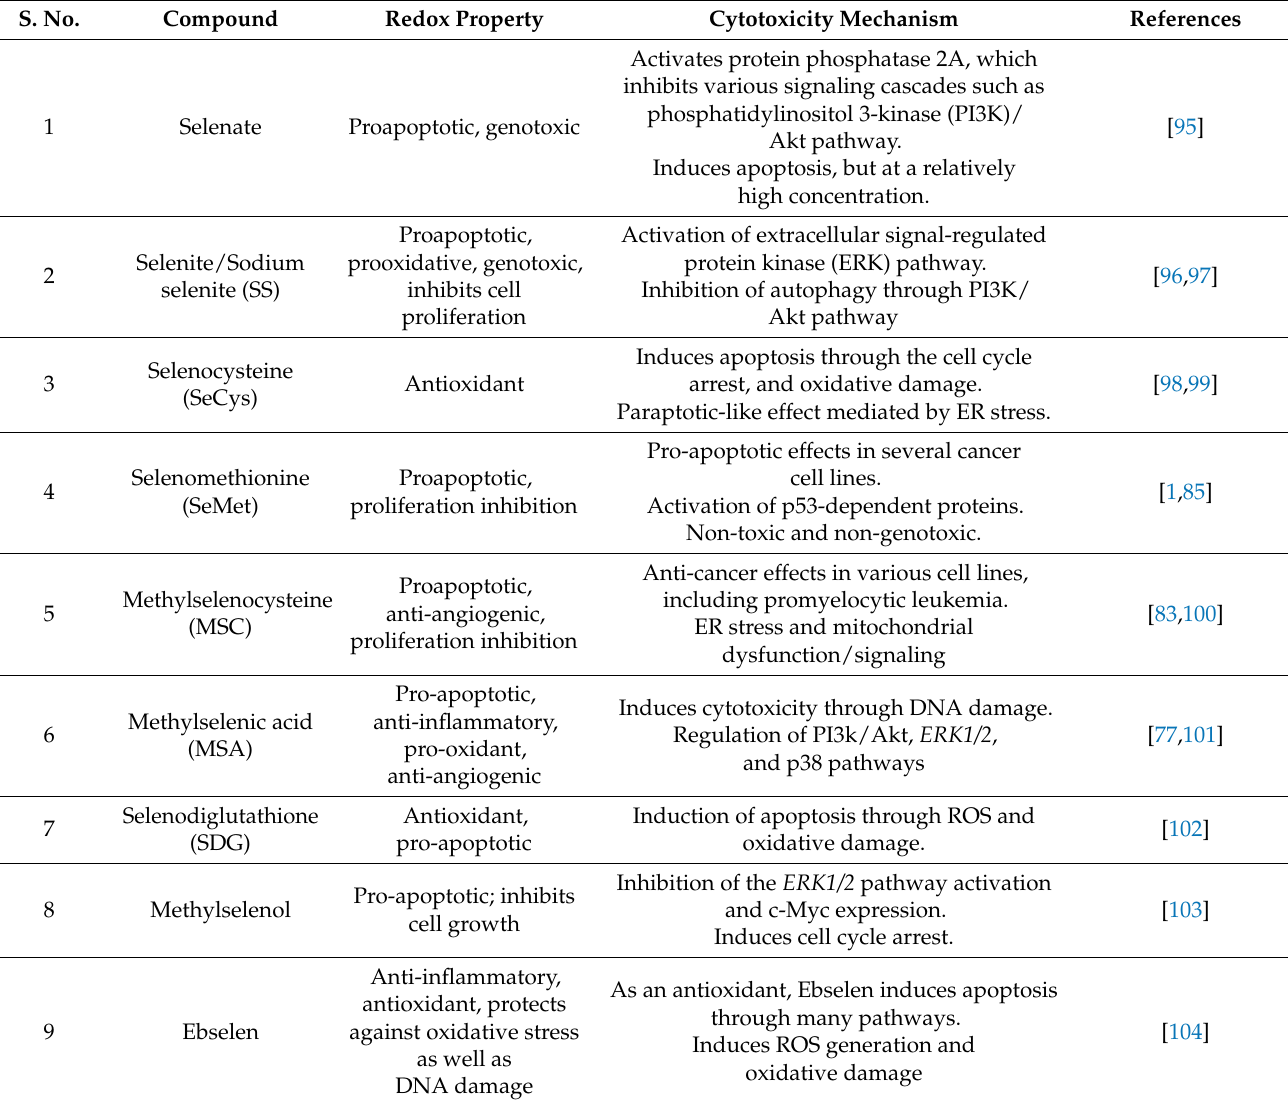
Table 1. List of selenium-based compounds with promising anticancer